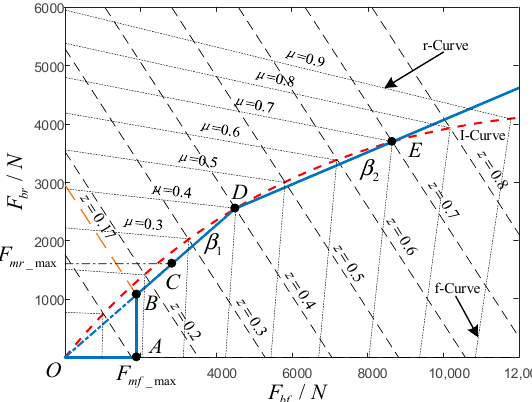
Figure 2. Braking force distribution curve of the front and rear axles.